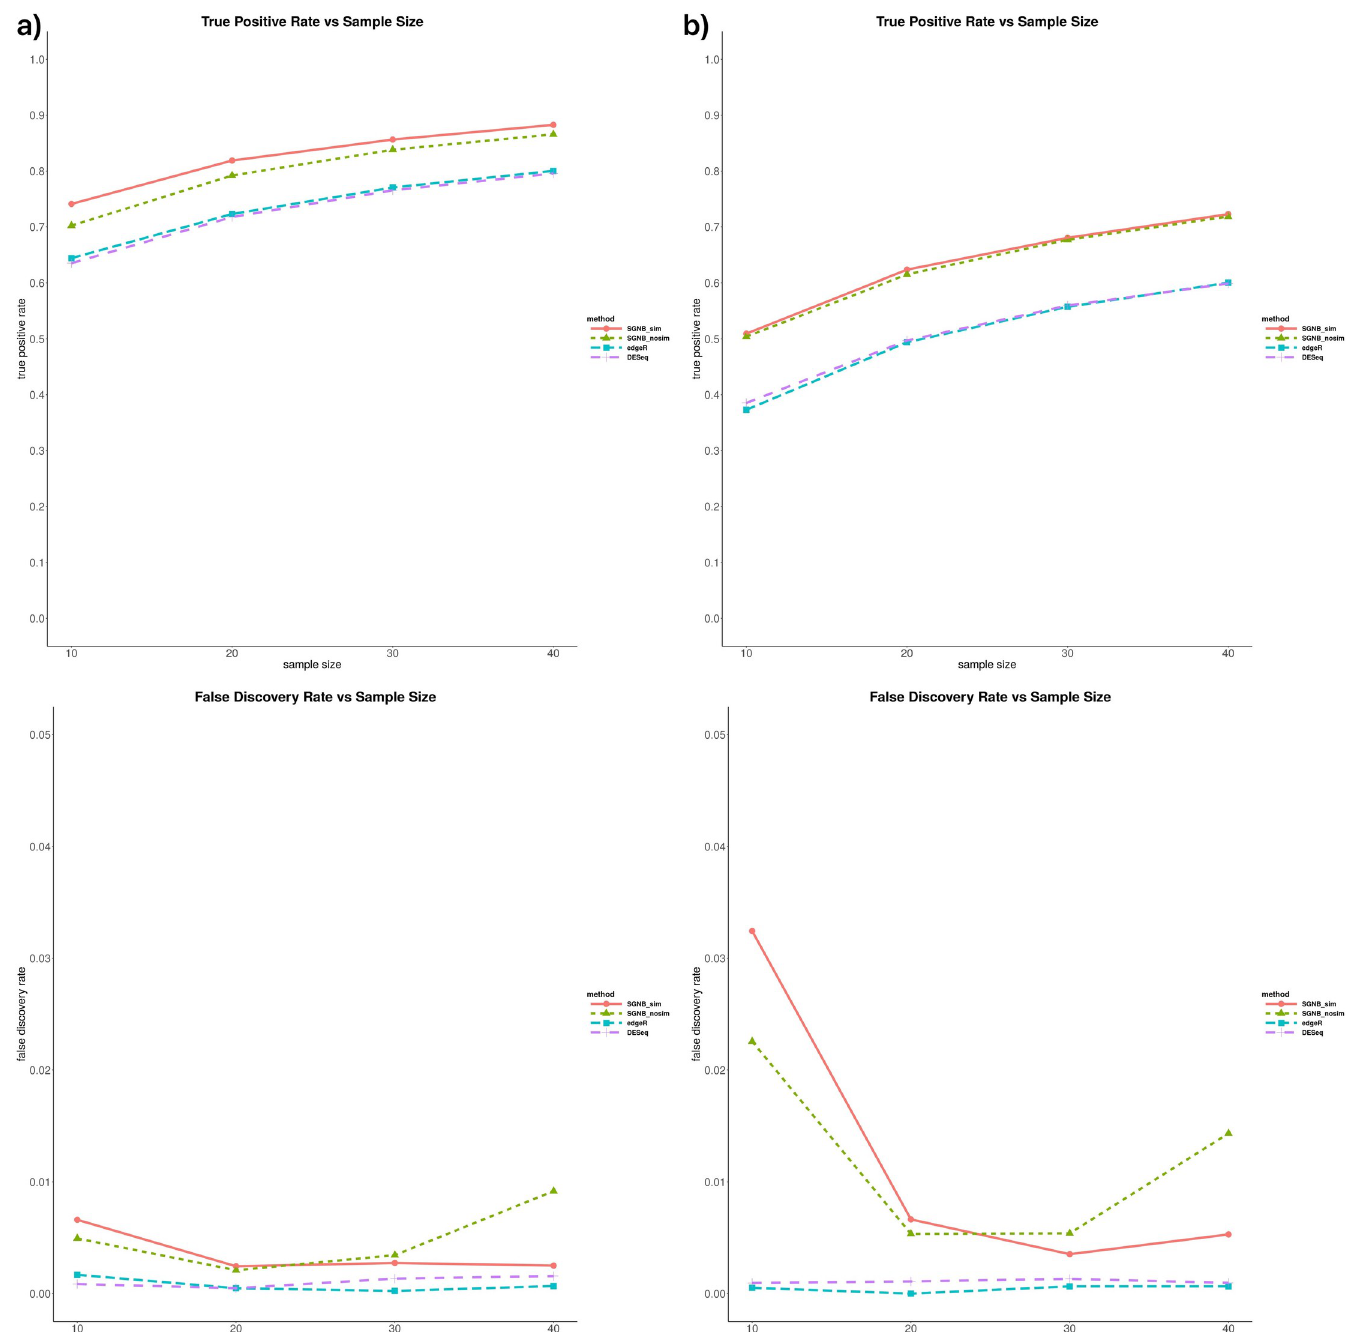
Fig 5. False discovery rate and true positive rate vs. sample size at 0.05 significance level. a) Small dispersion. b) Large dispersion.